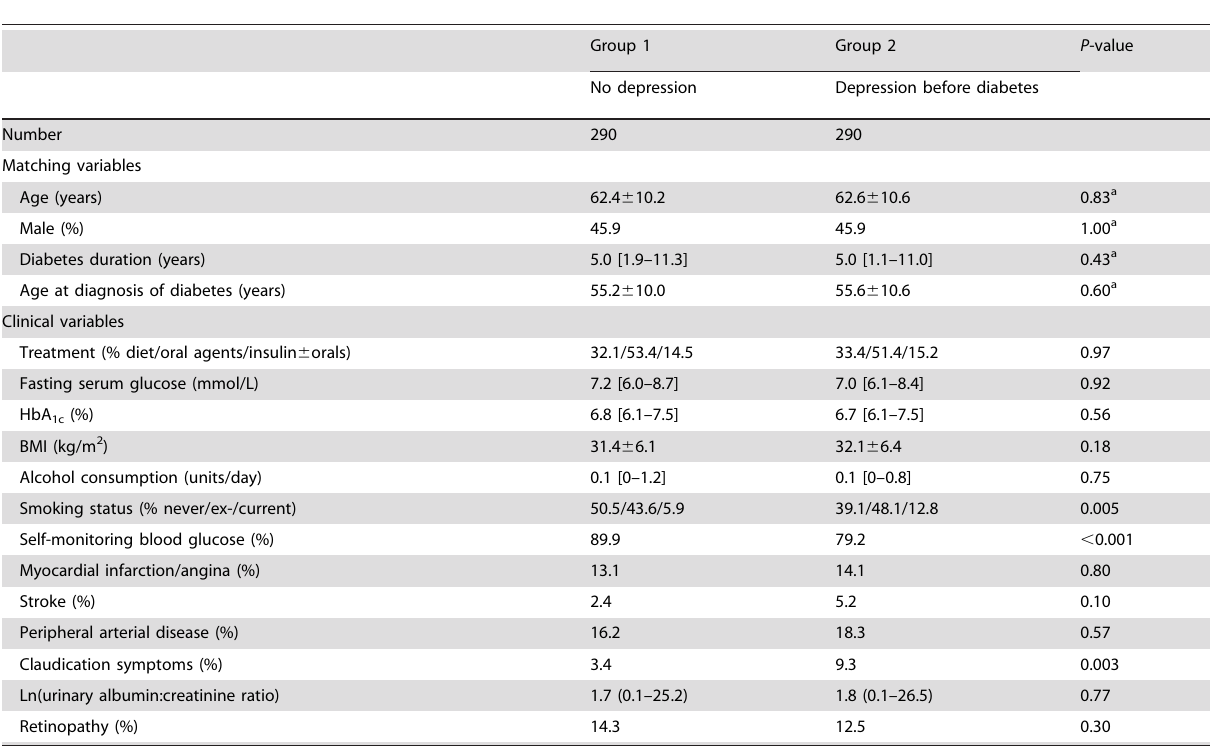
Table 3. Nested matched case control study comparing group 2 with group 1 patients matched by age, sex, and diabetes